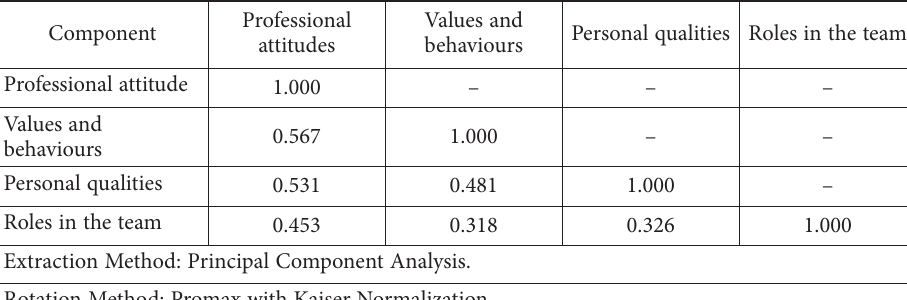
Table 2. Component correlation matrix of men’s participation in the innovation process of companies (source: Author’s work, with SPSS use)